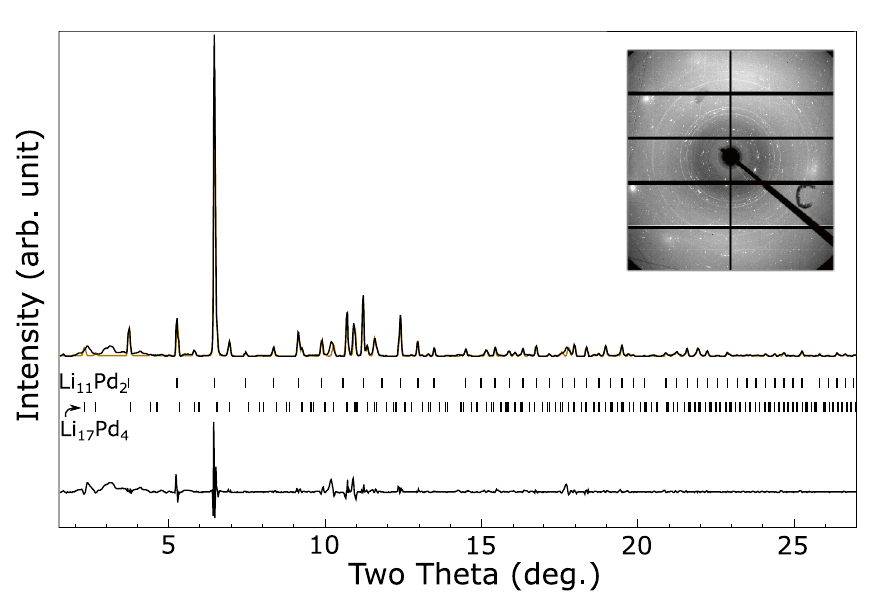
◦ C and 3.88 GPa (black), ¯ 43 m Li ¯ 43 m 17 Pd 4 ( a = 18.229 Å) and high-temperature I